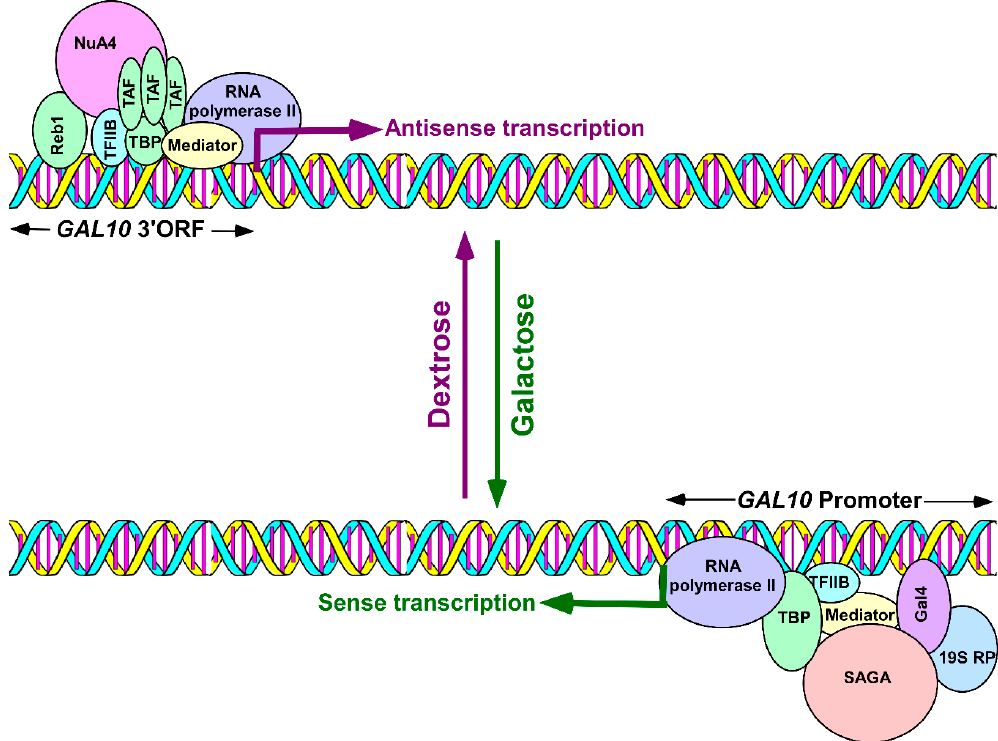
Figure 1. Schematic diagram showing GAL10 sense and antisense transcriptions in galactose and dextrose-containing growth media, respectively. Bottom panel: The activator, Gal4, targets the co-activator, SAGA, to the GAL10 upstream activating sequence to enhance the formation of PIC, via the Mediator complex, independent of the TAFs that initiate GAL10 sense transcription a in galactose-containing growth medium [88,89]. The 19S proteasome subcomplex, or 19S RP, enhances the targeting of SAGA to Gal4 independent of the proteolytic activity of the 26S proteasome [97]. Top panel: Reb1 targets NuA4 KAT to the 3 ′ -end of the GAL10 coding sequence ( GAL10 3 ′ ORF) for histone H4 acetylation and targeting of RNA polymerase II, via TFIID, to initiate GAL10 antisense transcription in dextrose-containing growth medium [83,84]. PIC—pre-initiation complex; SAGA—Spt-Ada-Gcn5-Acetyltransferase; TBP—TATA-box binding proteins; TAFs—TBP-associated factors; NuA4—Nucleosome acetyltransferase of histone H4; TFIID—Transcription factor IID, a complex of TBPs and a set of TAFs; TFIIB—Transcription factor IIB; and 19S RP—19S regulatory particle.